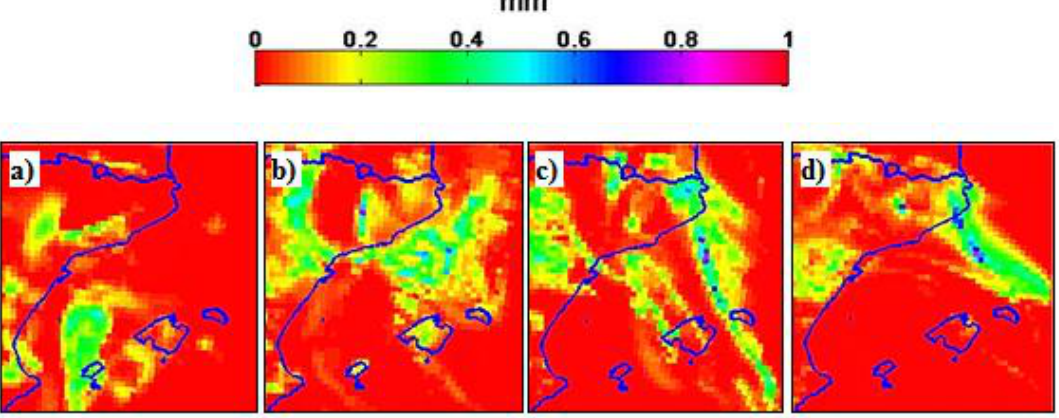
Fig. 12. Columnar cloud liquid water predicted by MM5 during the episode, where each image corresponds to the nearest hourly model output to the satellite passes: (a) 02:00 UTC 9 May, (b) 14:00 UTC 9 May, (c) 01:00 UTC 10 May, and (d) 13:00 UTC 10 May.